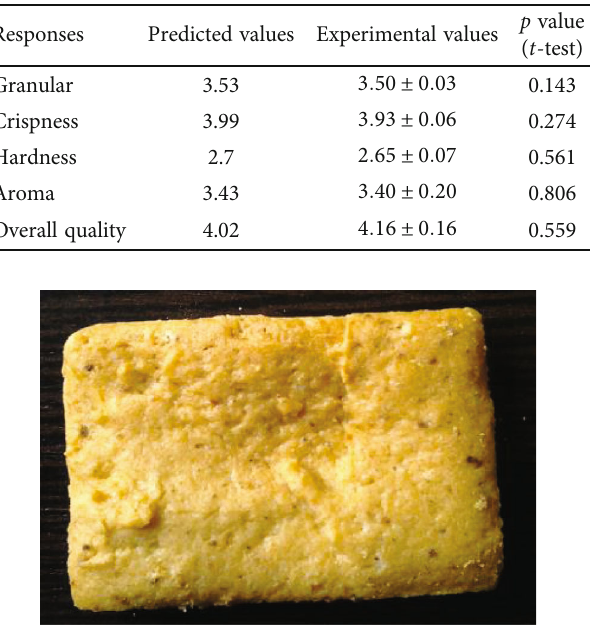
Figure 4: Optimized rice biscuit supplemented with safou.